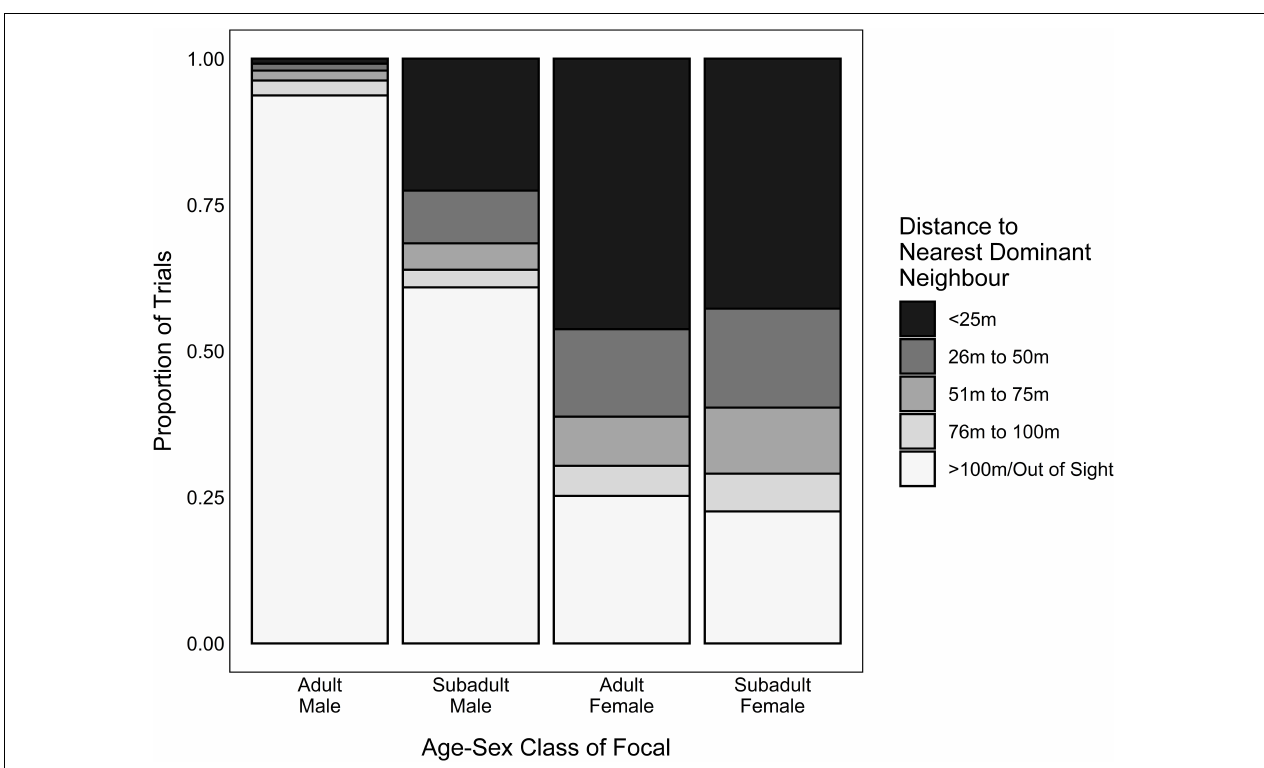
FIGURE 4 | Proportion of trials where the distance to the nearest dominant neighbor was within 25 m, 26–50 m, 51–75 m, 76–100 m or > 100 m/out of sight, for each age-sex class that participated in the foraging